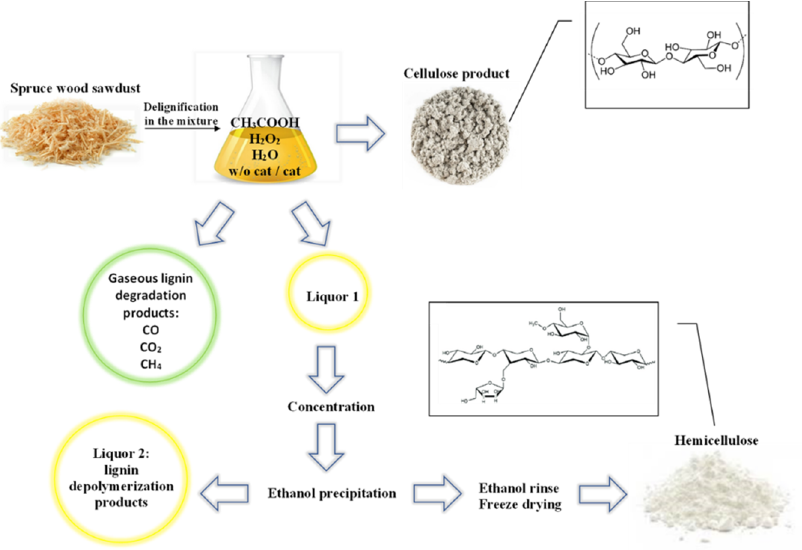
Figure 6. Scheme of the oxidative catalytic fractionation of spruce wood in the hydrogen peroxide ‐ acetic acid ‐ water medium with the formation of cellulose, hemicelluloses, and lignin products. The shredded spruce wood was delignified in a 250 ‐ mL glass reactor equipped with a stirrer and a reflux condenser. The delignification solution consisted of glacial acetic acid (30 wt%), hydrogen peroxide (6 wt%), and distilled water. The LWR was 15. In this study, four catalysts (NH 4 ) 6 Mo 7 O 24 , MnSO 4 , TiO 2 , and H 2 SO 4 with the high delignification effi ‐ ciency in a fraction of 1% of the wood weight were used. The delignification was per ‐ formed at temperatures of 90 °C and 100 °C for 3 and 4 h under constant stirring. After the completion of the delignification process, a fixed residue (the cellulosic product) was separated from the delignification liquids by filtration on a Büchner funnel, washing until neutral pH, and drying to the air ‐ dry state. Liquor 1 (Figure 6) containing delignification liquids was concentrated on a rotary evaporator. Then, hot (~60 °C) water was added in a volumetric ratio of 1:1 and driven off in a rotary evaporator. This procedure was performed twice to remove acetic acid. The HCs were precipitated with a fivefold volume of ethanol (96 wt%) under slow stirring and then held at a temperature of 4 °C for 12 h. The obtained white curdled HC precipitate was separated from the lignin depolymerization products (liquor 2 in Figure 6) by filtra ‐ tion on a Büchner funnel, washed with ethanol, frozen, and dried in an Iney ‐ 6 freeze dryer. The obtained HCs were analyzed by FTIR spectroscopy, GC, GPC, and TGA. The antioxidant activity was studied using compounds modeling free radicals: DPPH and hy ‐ droxyl radicals (ferrous sulfate FeSO 4 ). The elemental composition was examined. 3.3. Monosaccharide Composition of the Hemicelluloses To determine the monosaccharide composition, the HCs were hydrolyzed by a 2% HCl solution for 3 h. The individual composition and monosaccharide content in the hy ‐ drolysates were determined on a VARIAN ‐ 450 GC gas chromatograph equipped with a flame ionization detector on a VF ‐ 624ms capillary column with a length of 30 m and an inner diameter of 0.32 mm. The hydrolysate sample was pre ‐ derivatized by the technique described in [44] with the formation of trimethylsilyl derivatives. The silylation reagent was a mixture of trimethylchlorosilane and hexamethyldisilazane in pyridine; sorbitol was used as an internal standard (IS). Standards for analyzing the hydrolysates were glu ‐ cose, arabinose, galactose, sorbitol, mannose, and xylose (Panreac, Darmstadt, Germany). 3.4. Gel Permeation Chromatography